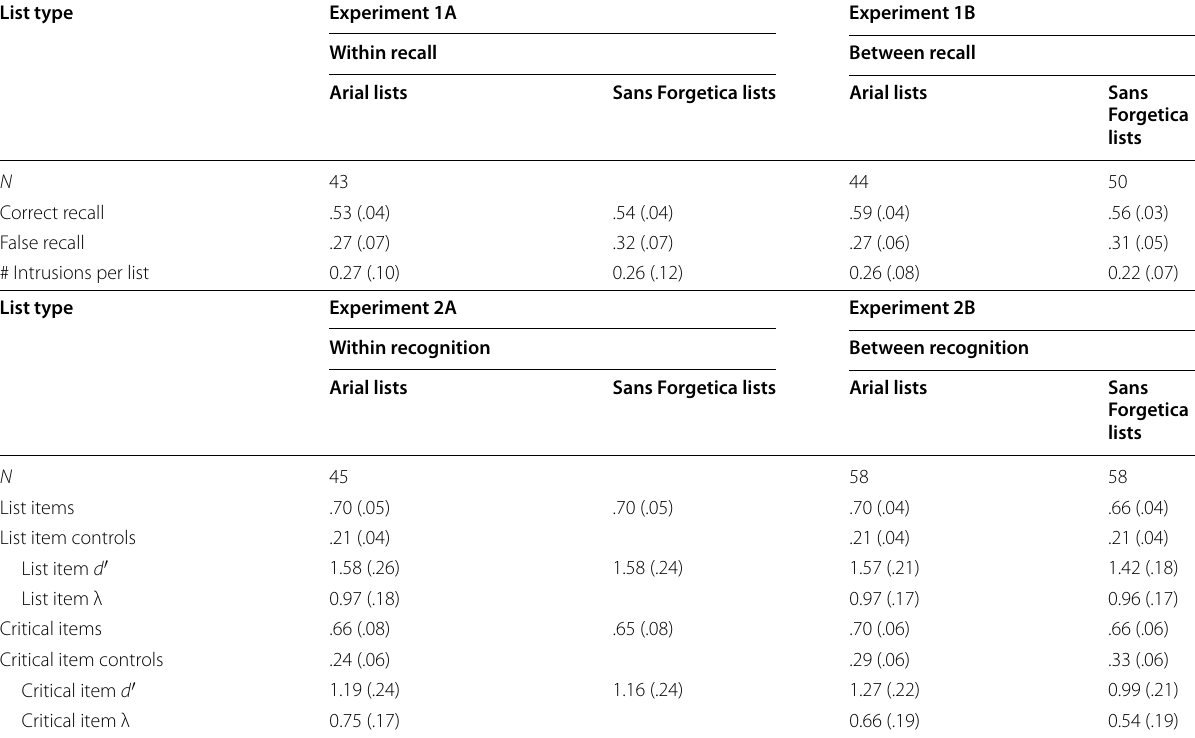
Table 1 Mean ( 95% CI) proportions of correct and false recall and “old” recognition responses and signal detection indices for lists ± presented in Arial font and Sans Forgetica font in Experiments 1 and